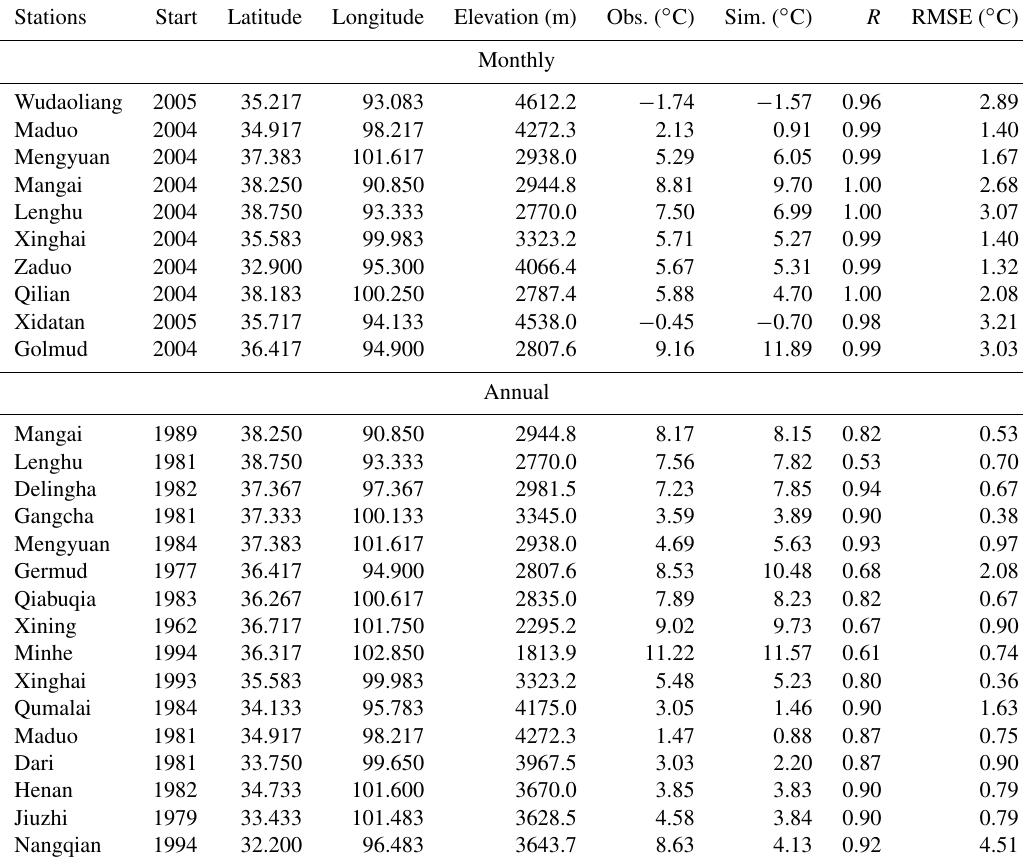
Table 3. Statistics of the observed and simulated monthly and annual mean soil temperature in 0–40cm depth. The observations end in 2009 for all stations except for Wudaoliang and Xidatan for which the observations end in 2006. R : correlation coefficient; RMSE: root mean square